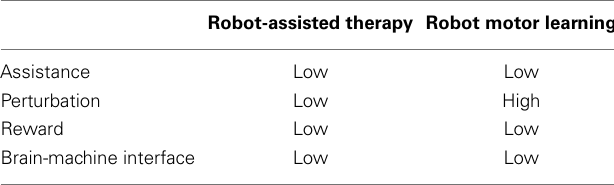
Table 1 | Levels of evidence for neuroplasticity in robot-assisted therapy and robot motor learning employing various elements